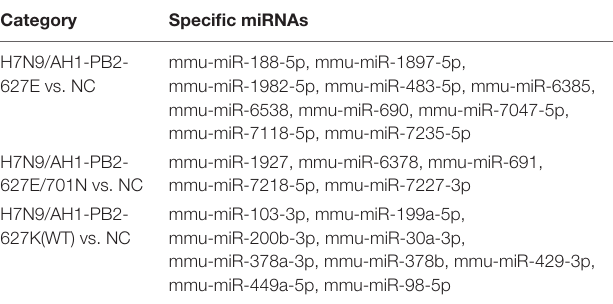
TABLE 3 | Specific downregulated miRNAs in lung tissues of mice induced by H7N9/AH1-PB2-627K(WT) and its mutant viruses.